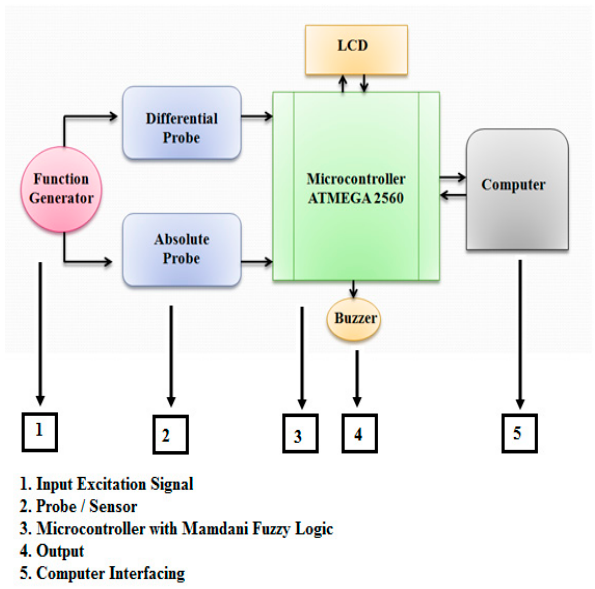
Figure 2. Proposed Architecture of Error Compensation Eddy Current Testing (ECECT) System.